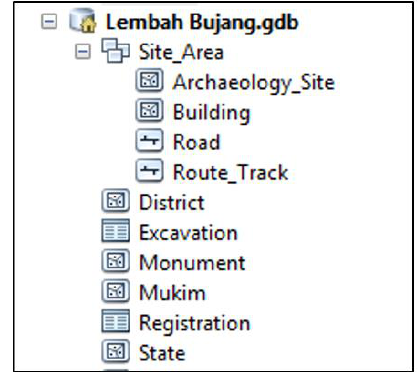
Figure 8 : File geodatabase in